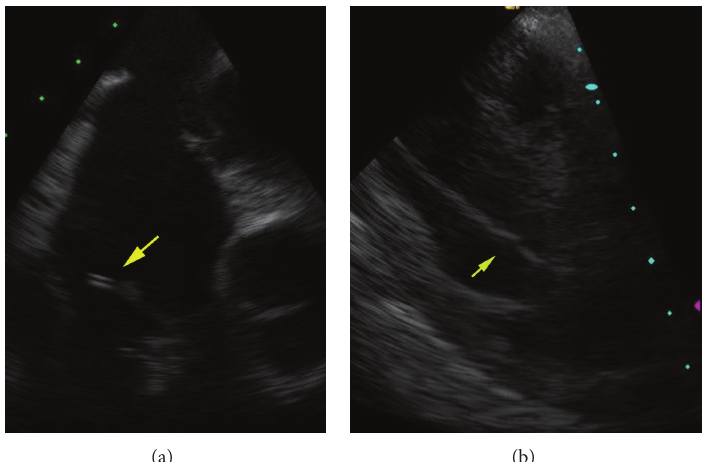
Figure3:(a)Intracardiacultrasound-dislodgedcatheter(arrow)isextendingacrossthetricuspidvalve.(b)Intracardiacultrasound-dislodged catheter (arrow) is seen in the right